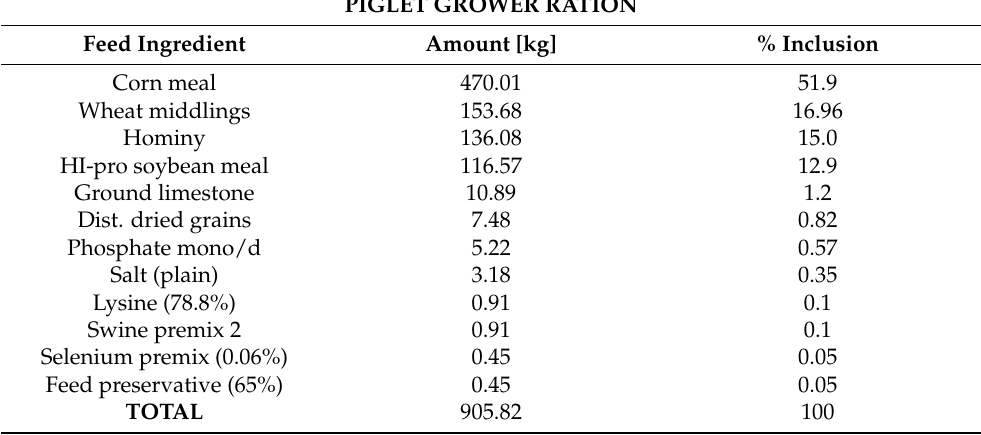
Table 3. Composition of Piglet Grower